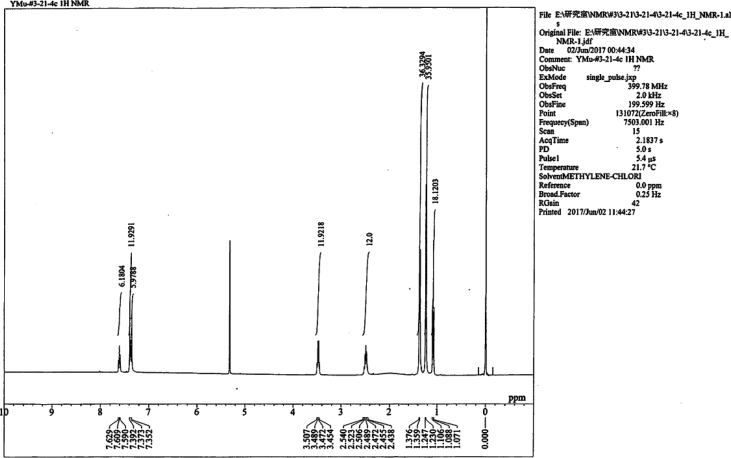
1H NMR spectrum of [Au(H2O)(IPr)]3[α.PW12O40] (2) in CD2Cl2 at 21.7 °C.